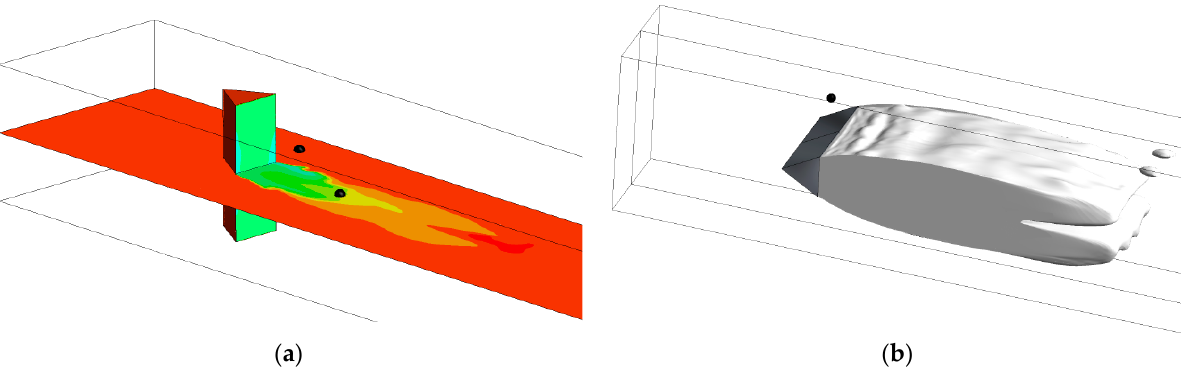
Figure 6. 3D view, σ = 2.221. ( a ) Distribution of temperature on cylinder surface and at test section mid-plane; ( b ) shape of cavities behind cylinder.